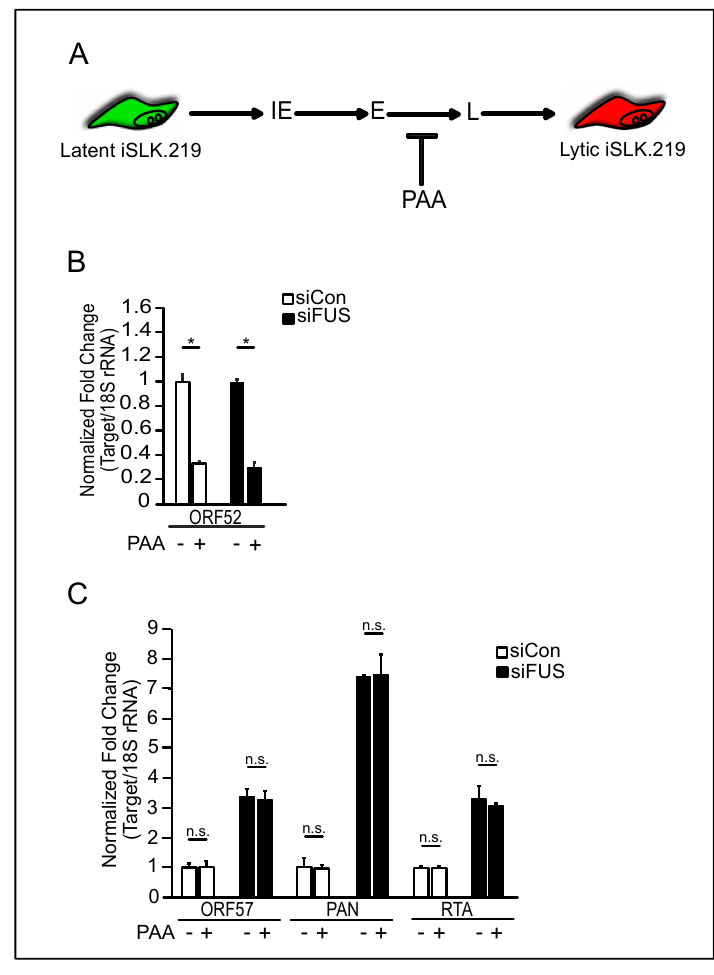
Figure 5. FUS restricts viral reactivation prior to DNA replication. ( A ) Schematic of the herpesviral gene expression cascade. Phosphonoacetic acid (PAA) treatment blocks viral DNA replication, thereby blocking late viral gene expression. IE, immediate early; E, early; L, late ( B ) Total RNA isolated from iSLK.219 cells reactivated for 48 h and transfected with either siCon or siFUS and treated with PAA, was subjected to RT-qPCR to monitor expression of ORF52. All samples were normalized to 18S. The non-PAA treated samples for both siCon and siFUS were normalized to 1 and compared to the PAA treated samples. ( C ) RT-qPCR of ORF57, PAN, and RTA viral genes from iSLK.219 cells treated with same conditions as ( B ) and collected at 24 h post reactivation. All samples were normalized to 18S. For each condition and gene, siCon was set to 1. Student t test used to determine statistical significance * p < 0.05, n.s. not significant.